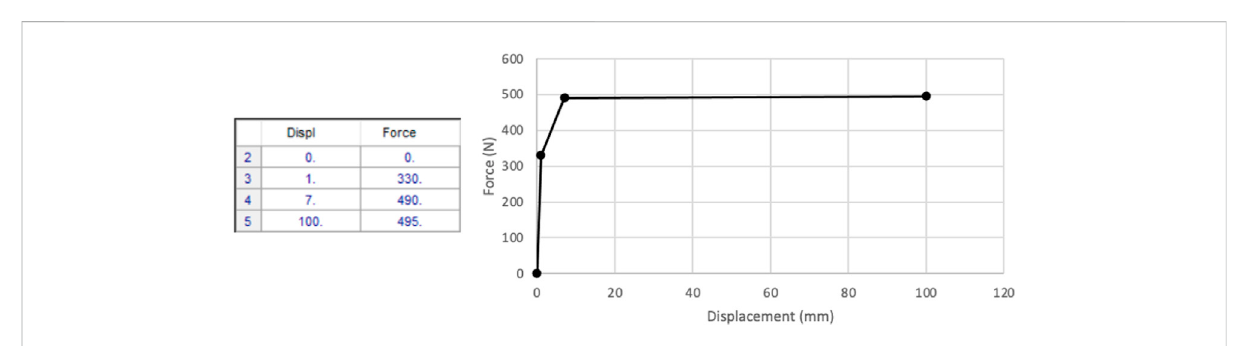
FIGURE 4 Load-deformation curve data points for 3-nail toe-nailed connections in model.